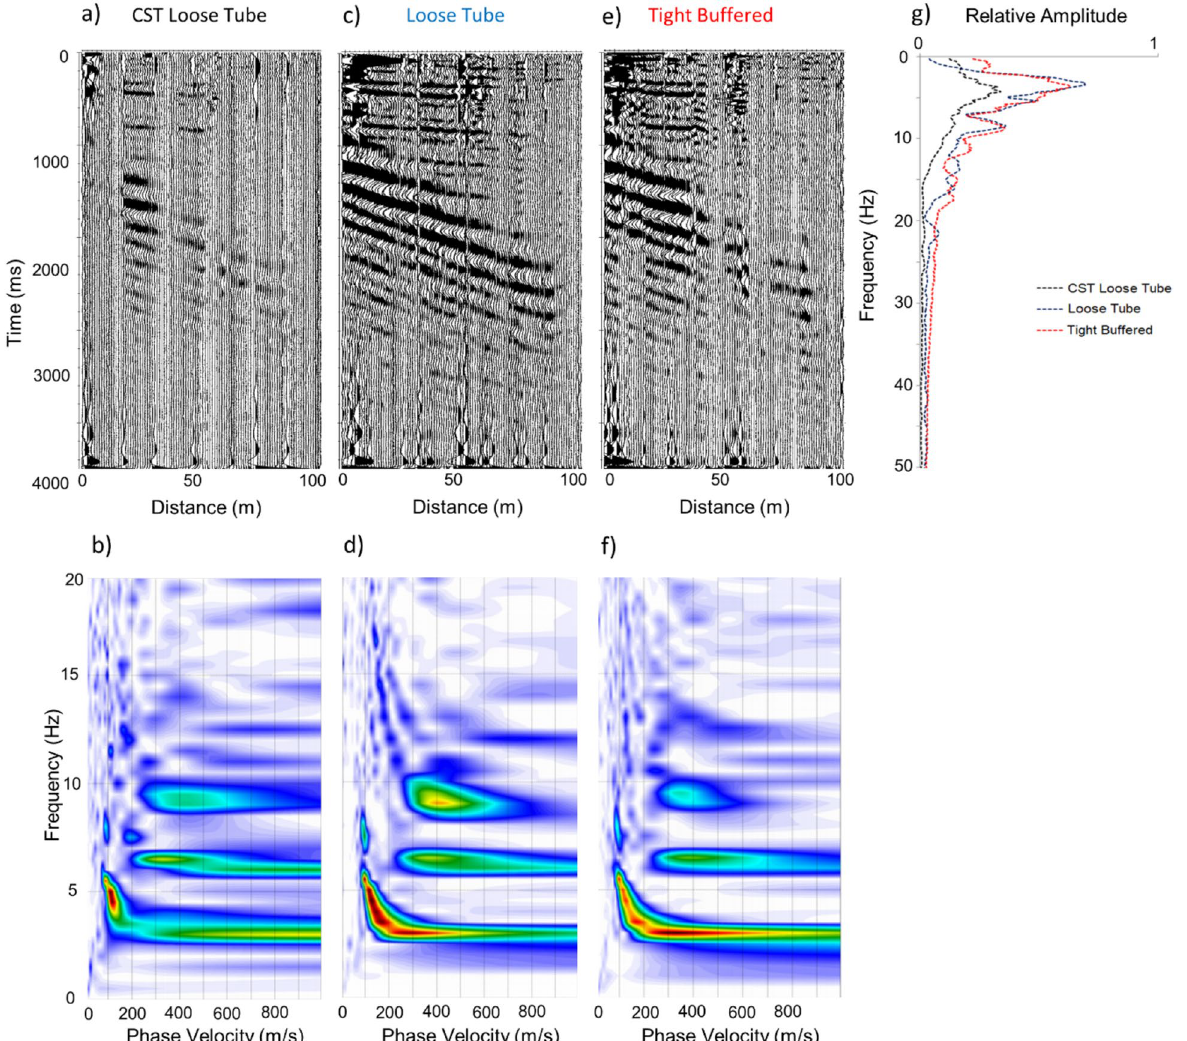
Figure 4. Seismic shot gathers and corresponding dispersion images acquired using ( a & b ) CST loose tube cable, ( c & d ) loose tube cable, ( e & f ) tight buffered cable. Relative amplitude vs frequency for each of the cable variants is shown in ( g